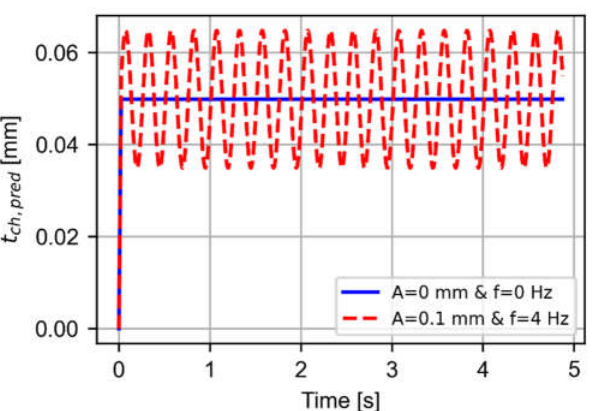
Figure 7. Predicted uncut thicknesses when boring at different vibration conditions (red line A = 0.1 mm and f = 4 Hz and blue line A = 0 corresponding to conventional cutting).